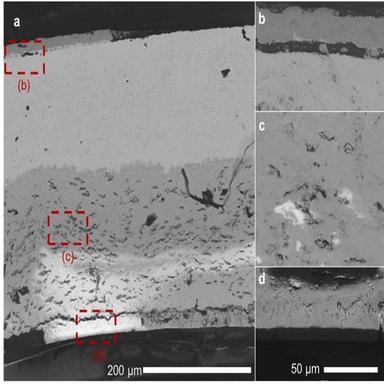
SEM cross-section of Cr-coated OPZ quenched from 1000 ◦C; (a) full cross-section; high magnification views: (b) Cr-coating; (c) porous, breakaway oxide; (d) stable oxide including passivation and columnar layers. Fig. 7. SEM cross-section of uncoated OPZ Quenched from 900 ◦C.